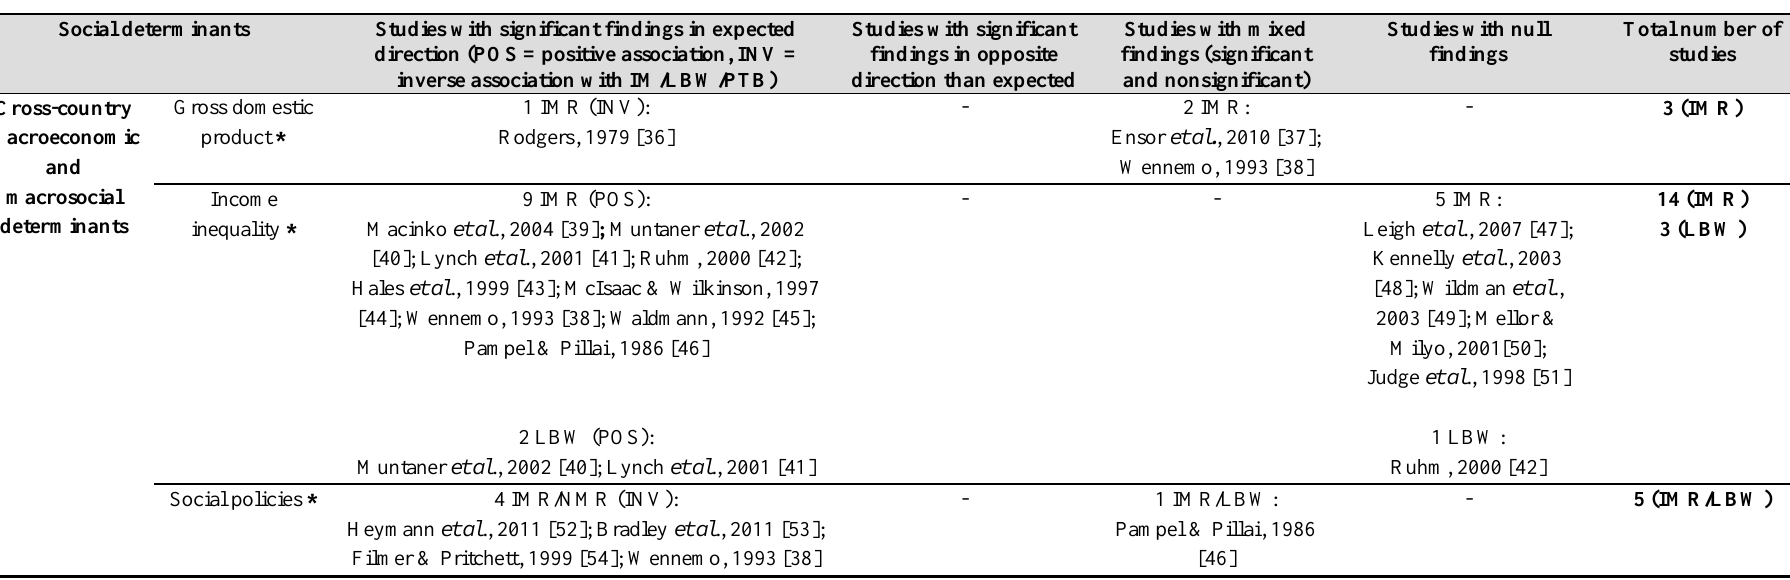
Table 1. Distribution of studies of the relations between social determinants and IM/birth outcomes, by direction and significance of findings. Social